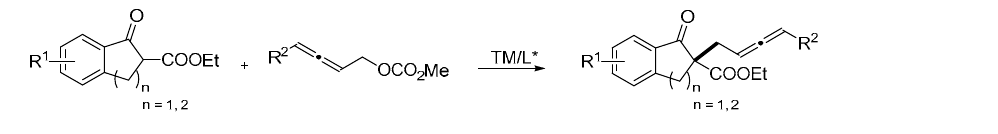
Scheme 1. Representative allenes with different functions, different methods for the synthesis of allenes and construction of 1,3-stereocenters bearing allenyl axial and central chirality.